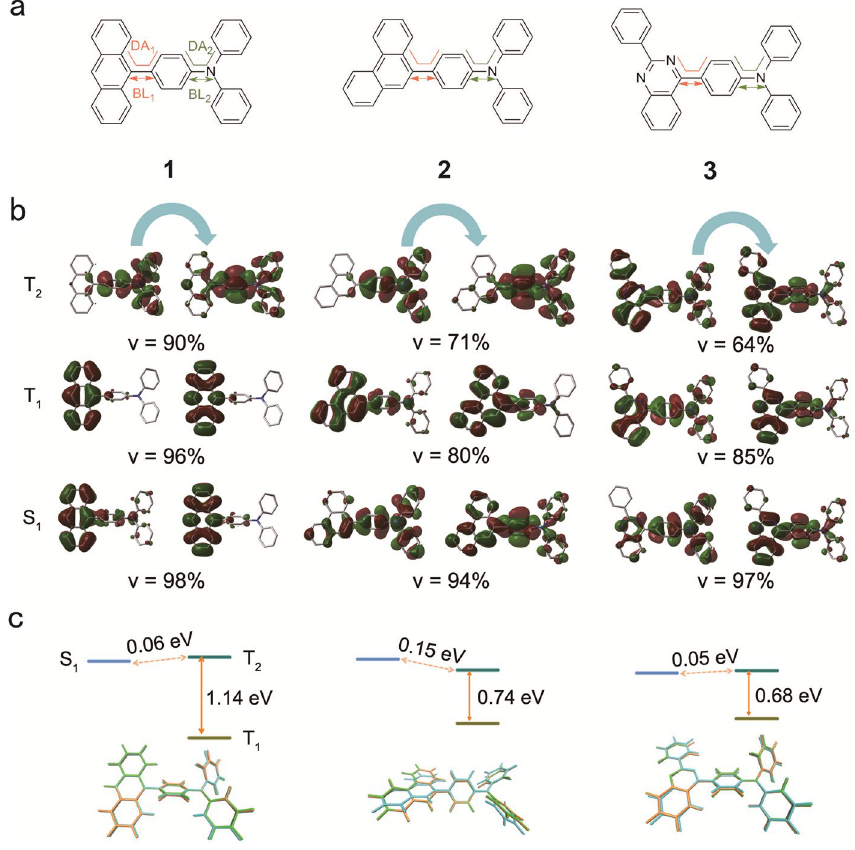
Figure 2. (a) Molecular structures of 1 , 2 , and 3 . (b) Natural transition orbitals of S 1 , T 1 , and T 2 excited-state with M06-2X/Def2SVP based on ground-state structures. (c) Relative S 1 , T 1 , and T 2 energy levels with M06-2X/ Def2SVP and a structural comparison among S 1 , T 1 , and T 2 structures. S 1 (orange); T 1 (green); T 2 (cyan). (b) Drawn by GaussView 6.0 and Multiwfn programs; (c) is drawn by VMD 1.9.1.